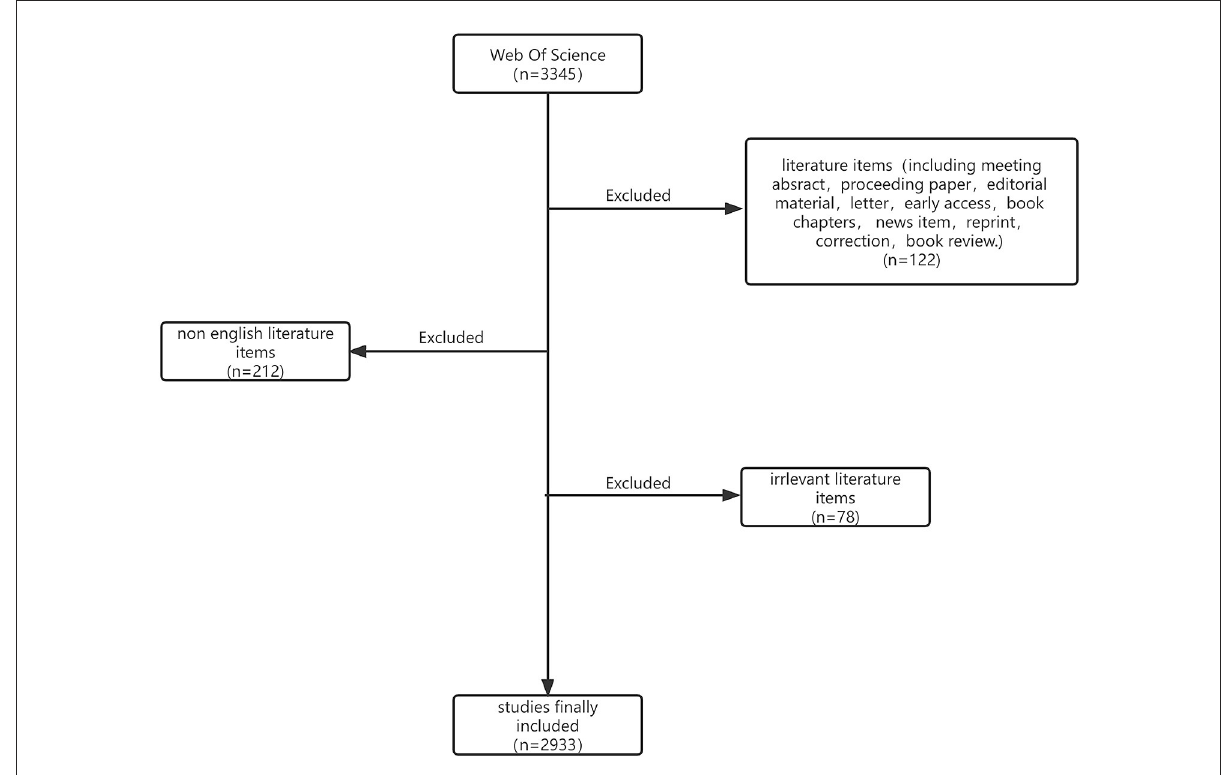
FIGURE1 Flow diagram of the included